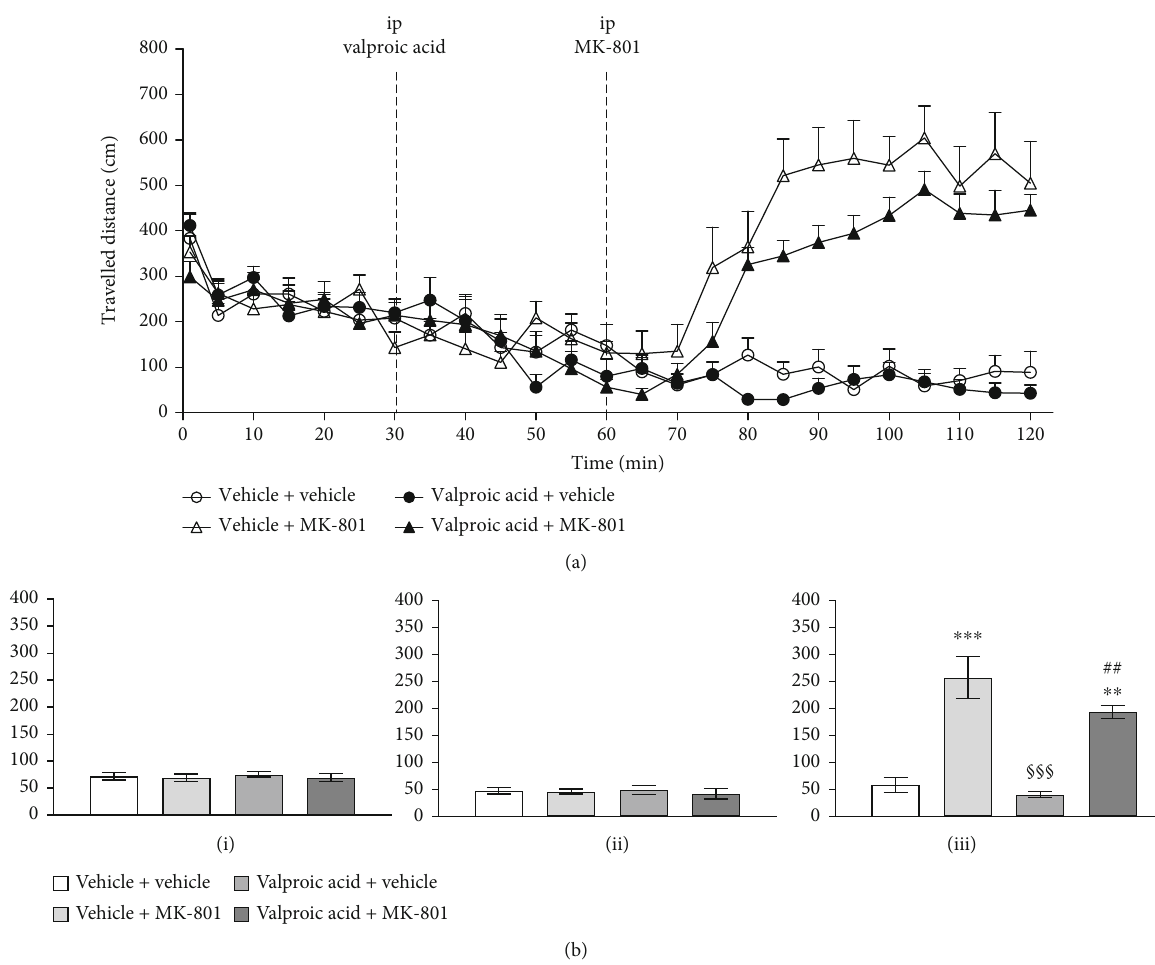
Figure 2: The travelled distance (cm) at the corresponding time points in the open fi eld test following the valproic acid and MK-801 injection (a). Comparisons of the total travelled distance (m) for each drug treatment group (b); vertical bars represent SEMs: (i) represents baseline within 0 – 30 minutes, (ii) represents valproic acid drug e ff ect during 30 – 60 minutes, and (iii) represents MK-801- injected travelling change during 60 – 120minutes; total travelled distances are shown in meters. Subject numbers were 10 – 11 in each group. Di ff erences among the study groups were evaluated by ANOVA and post hoc analysis. Statistically signi fi cant di ff erences between groups: ∗ p < 0 : 05 , ∗∗ p < 0 : 01 , and ∗∗∗ p < 0 : 001 vs. vehicle+vehicle; # p < 0 : 05 , ## p < 0 : 01 , and ### p < 0 : 001 vs. valproic acid + vehicle; §